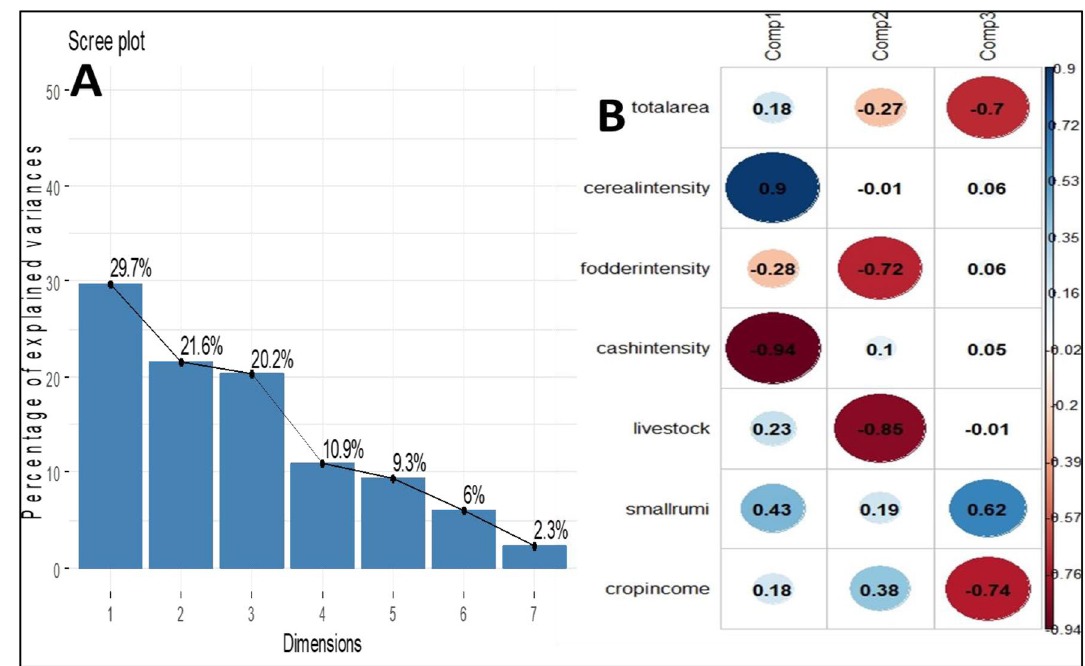
Figure 2. PCA result output: ( A ) Scree plot ( B ) Correlation plot of PCs with